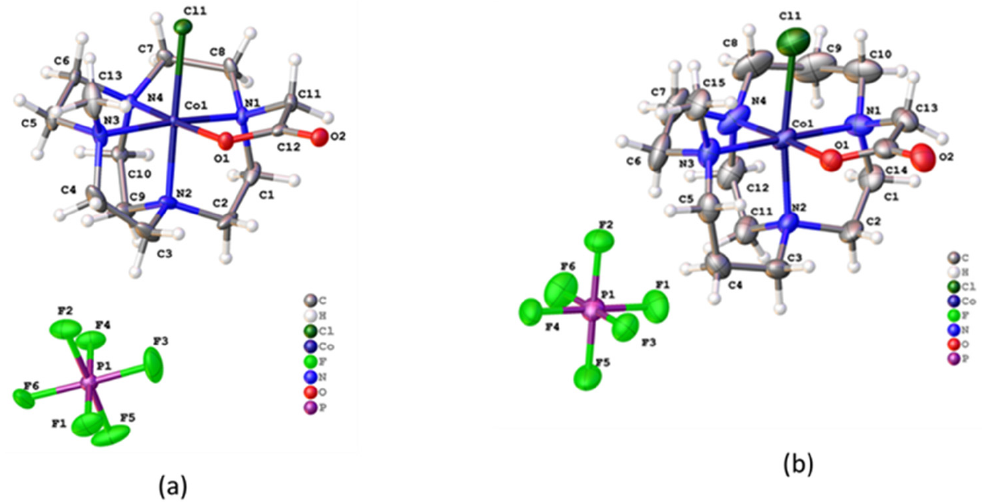
Figure 3. The asymmetric unit of ( a ) [Co L 1 Cl]PF 6 and ( b ) [Co L 2 Cl]PF 6 with atoms shown as 50% probability ellipsoids.